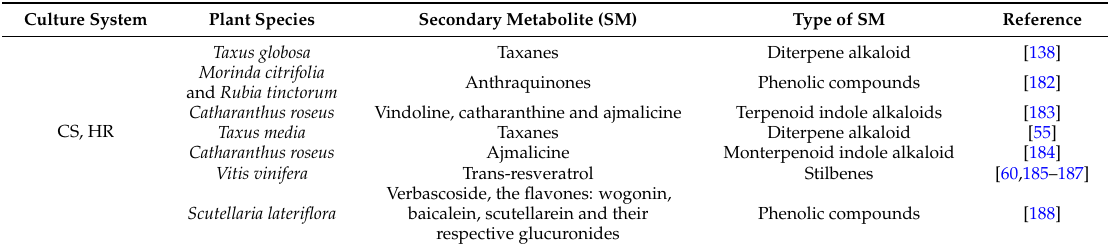
Table 2. Effect of cyclodextrins on secondary metabolite production in plant in vitro cultures. Culture